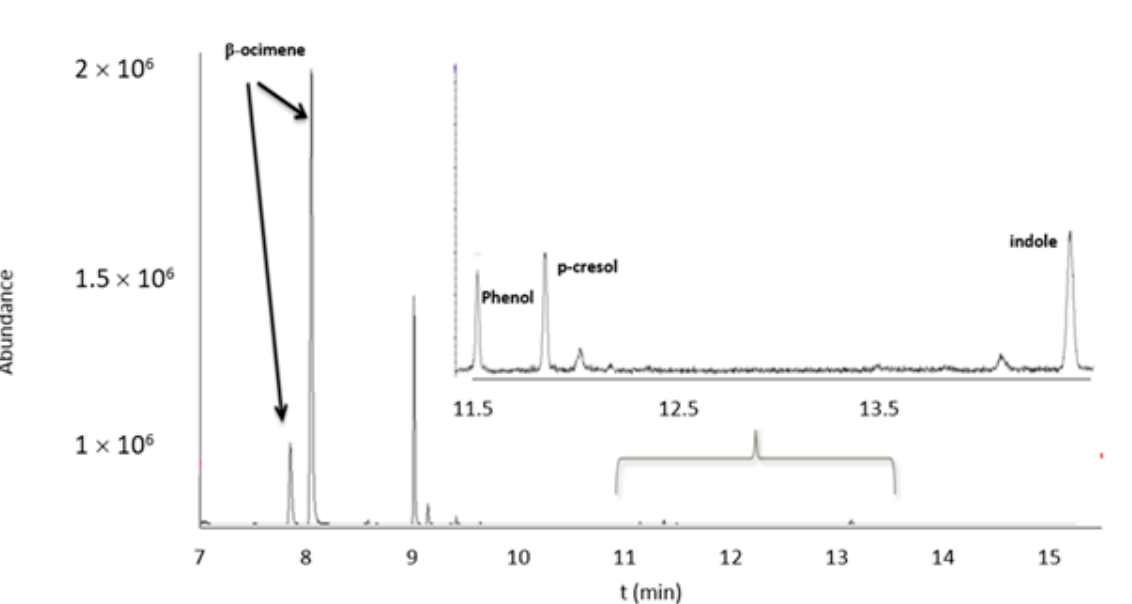
Figure 3. Chromatogram obtained from analysis by HS-GC/MS of the mixture of bioattractants ( β -ocimene, phenol, p-cresol, and indole) in concentration 10 mg/L. Table 1. Experiment matrix for CCD.